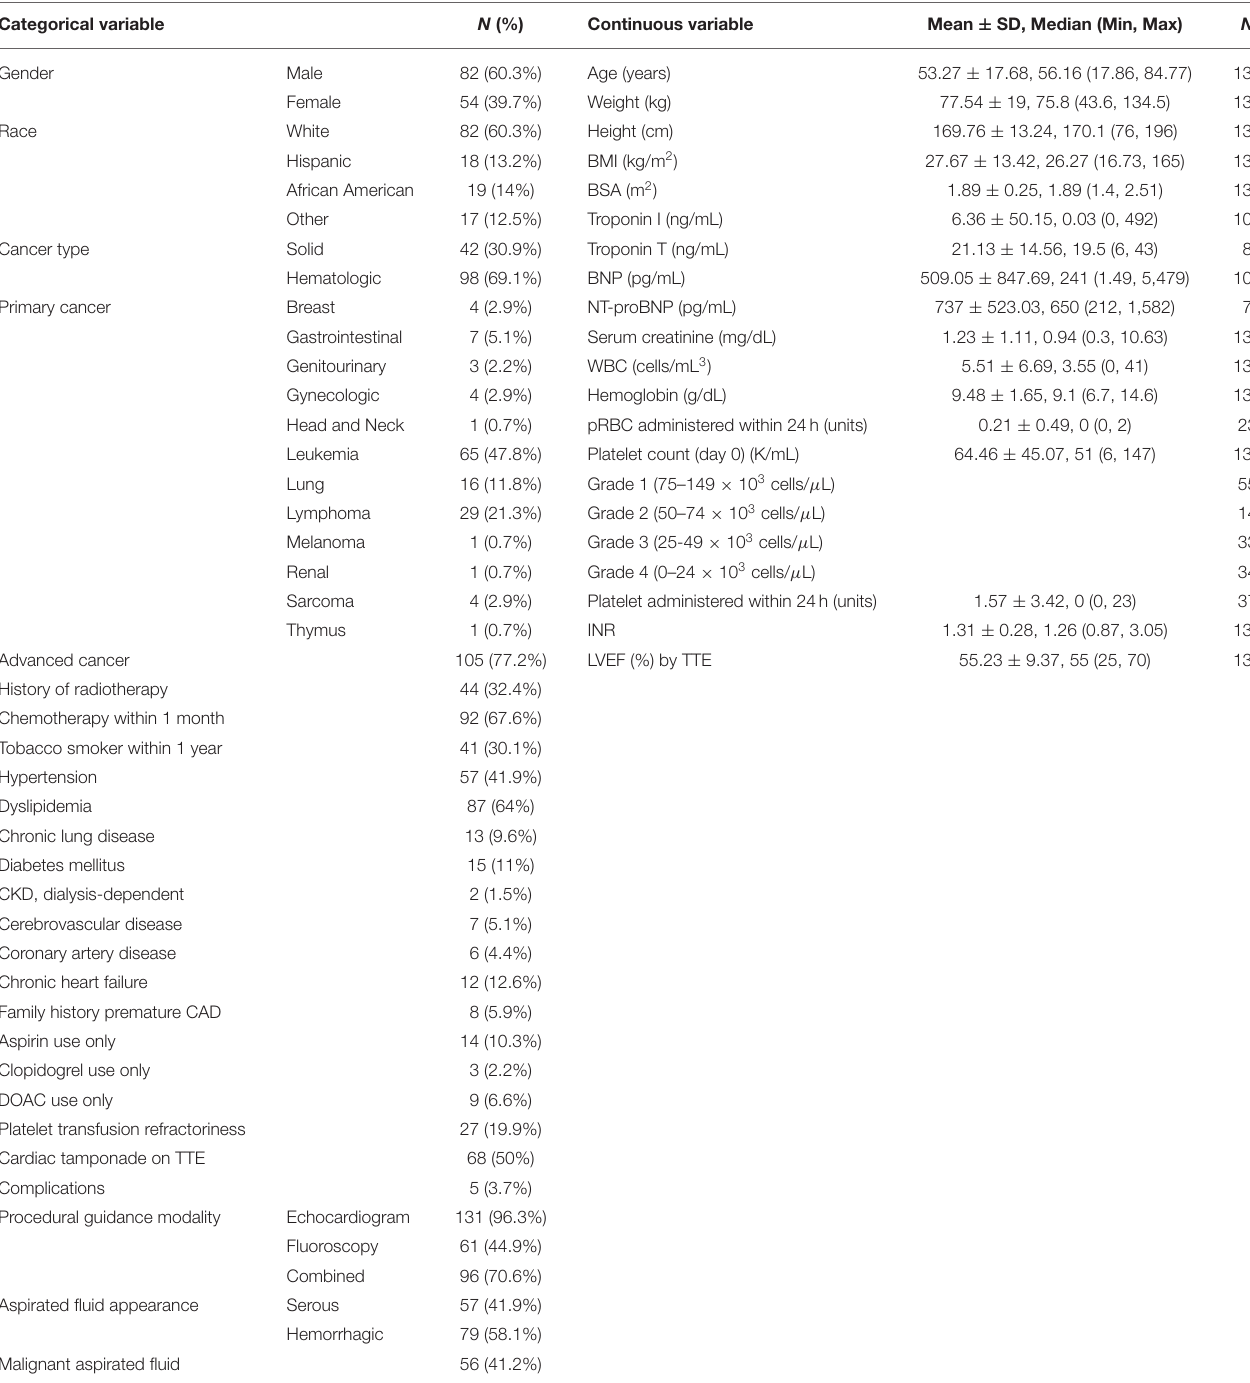
TABLE 1 | Descriptive statistics of patient